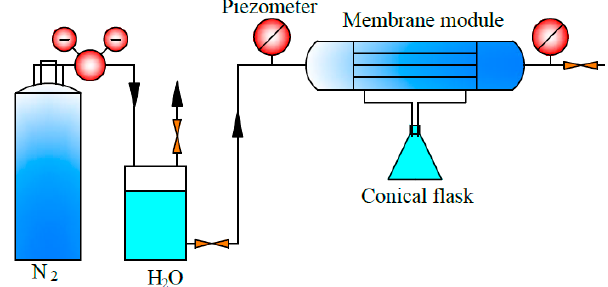
Figure 2. Test device diagram for water flux of the PEEK hollow fiber membrane.